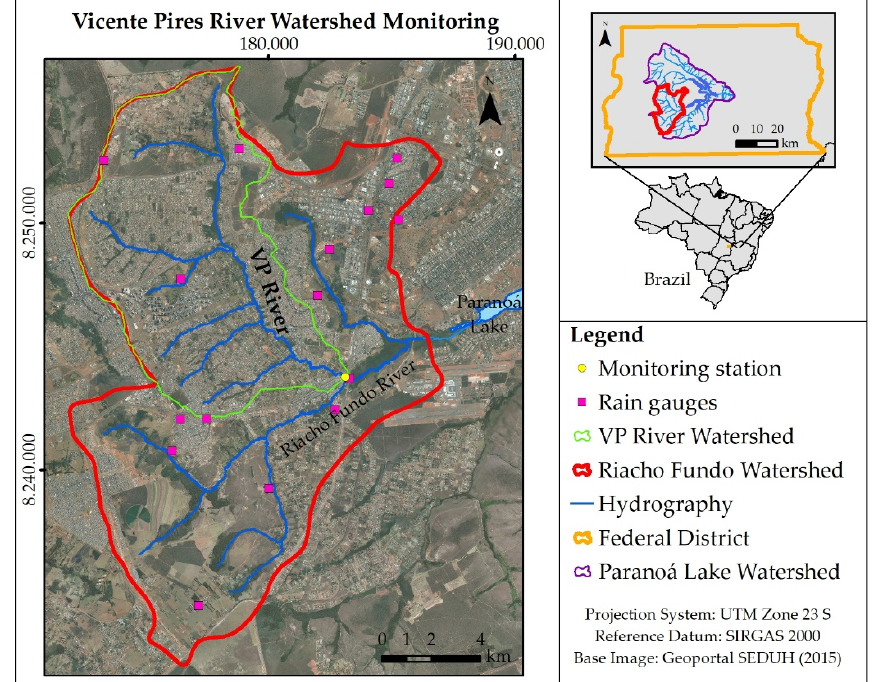
Figure 1. Location of the study area: Vicente Pires Watershed in the Federal District, Brazil.